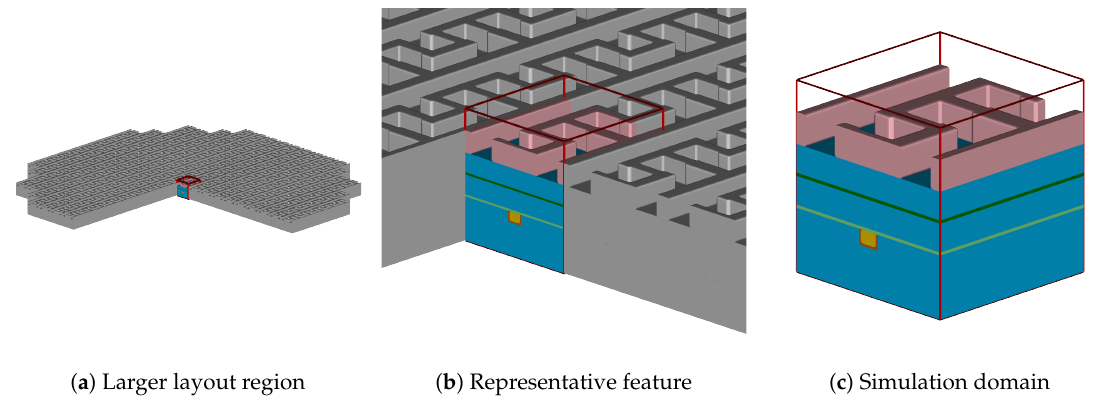
Figure 1. ( a ) a larger region of a layout on a wafer; ( b ) close-up on a representative feature; ( c ) feature-scale simulation domain with domain boundaries in